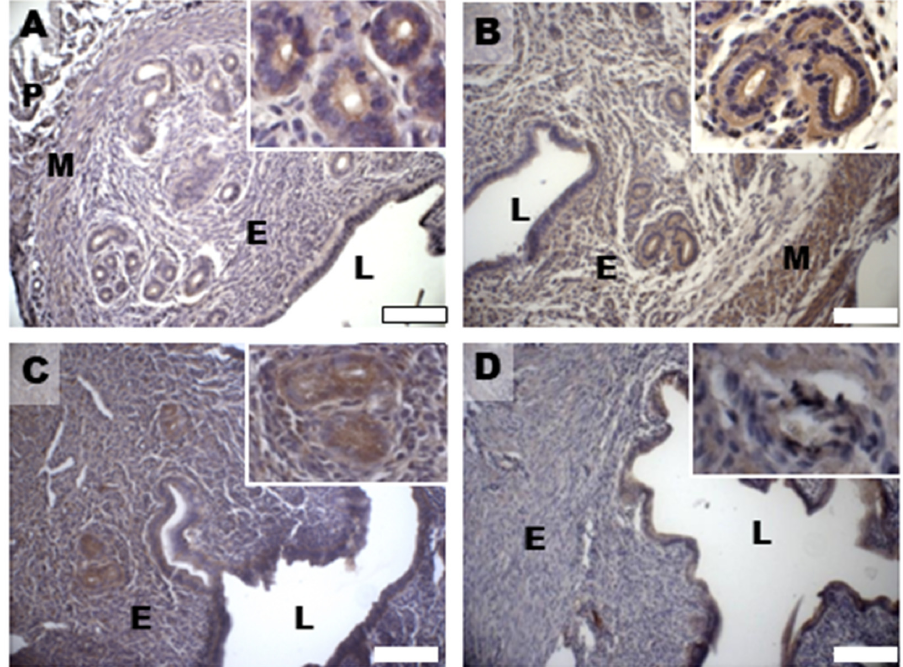
Figure 6. Immunostaining of mouse uterine horns for 17 β‐ HSD4 ( A – D ) of control ( A ), DHEA ( B ), DHEA/LC ‐ ALC ( C ) and DHEA/LC ‐ ALC ‐ PLC ( D ) groups. Insets show details of the glandular epi ‐ thelium. L: lumen; E: endometrium; M: myometrium; P: perimetrium. LM, mag. 10x. Insets: